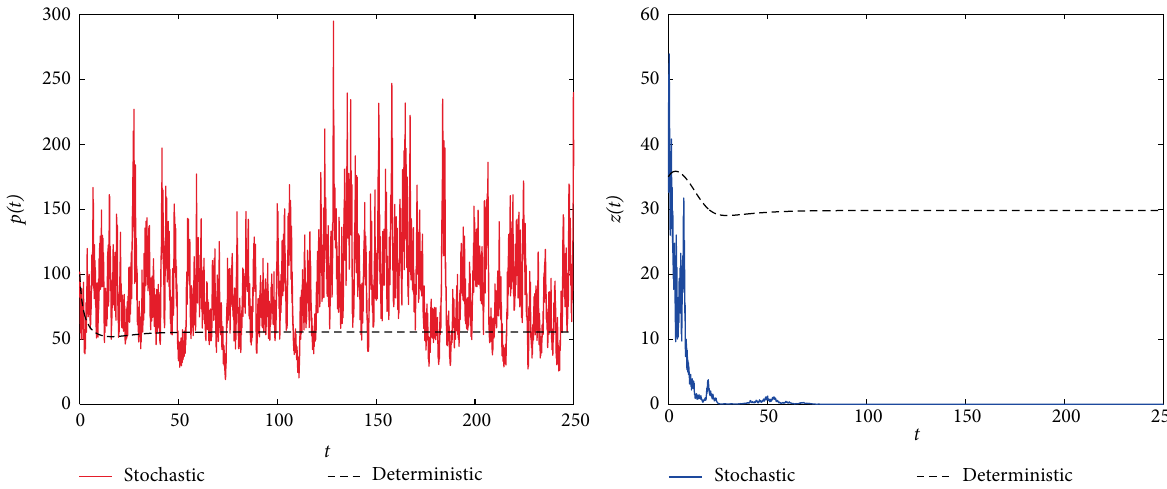
= 0.5, 𝜎 = 0.5 and other parameters are taken as 1 2